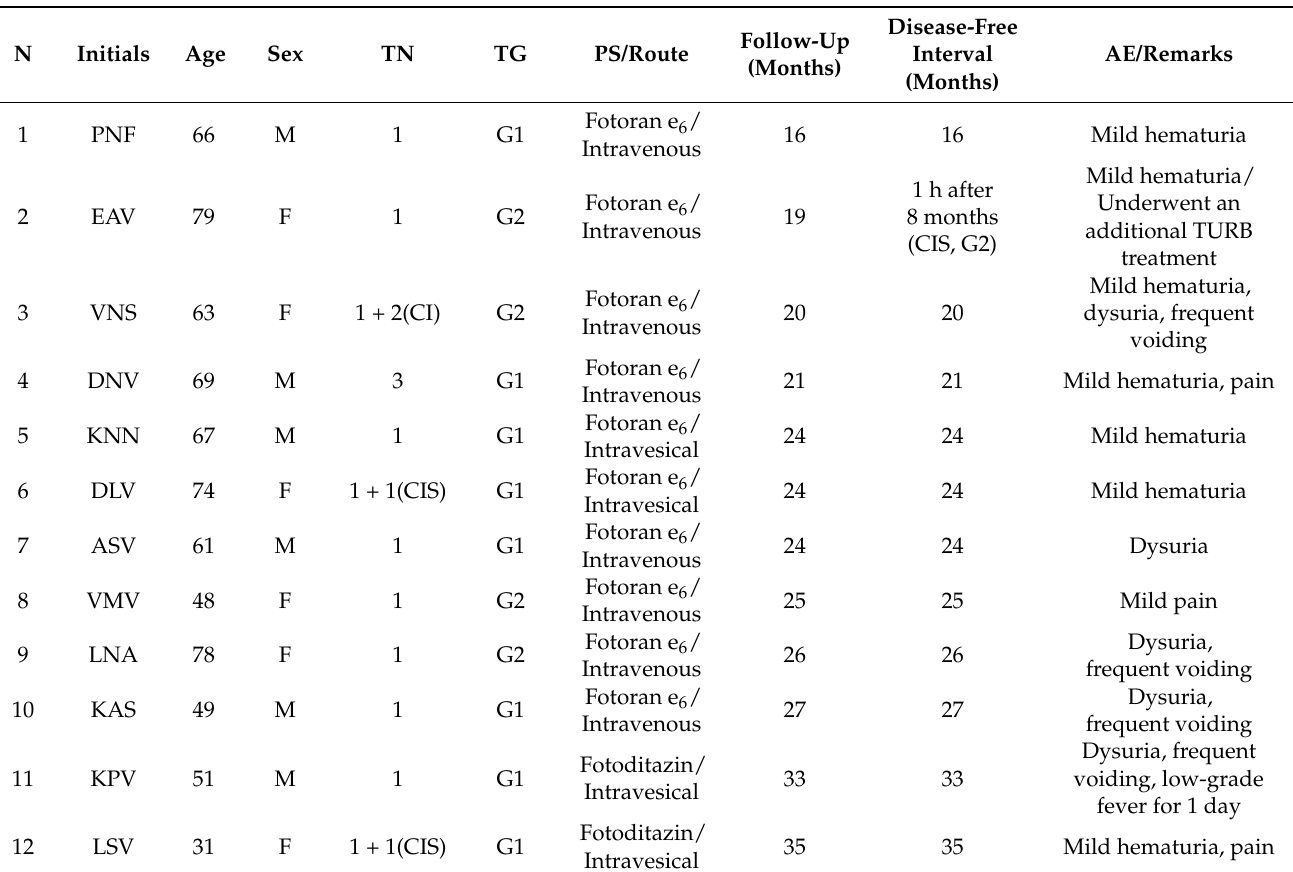
Table 2. Patient characteristics and TURB + FD + PDT outcomes 1